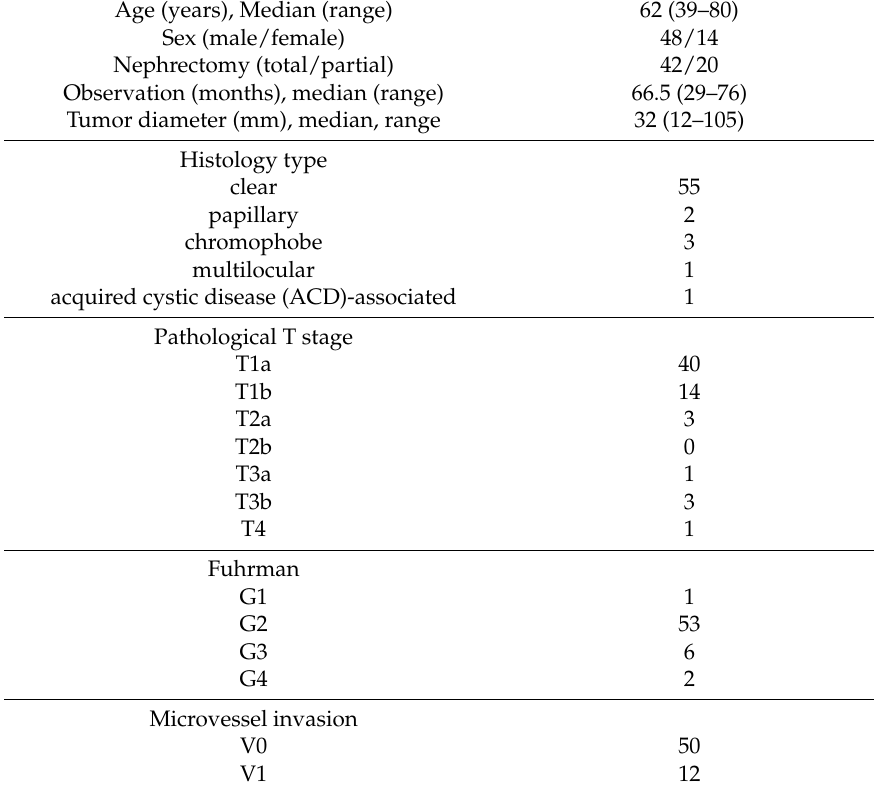
Table 1. Patient and tumor characteristics of 62 cases with localized renal cell